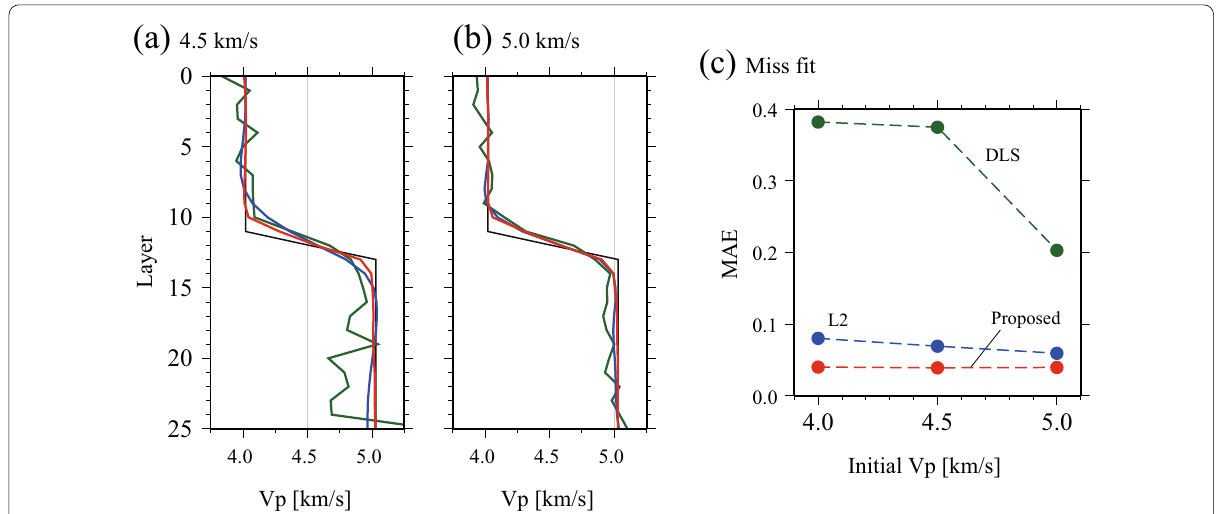
Fig. 7 Recovery of the estimated average velocities for different initial velocities: a 4.5 km/s and b 5.0 km/s. c MAE variations arising from the initial velocities for the different estimation methods. Colored lines in a , b are the same as those in Fig.